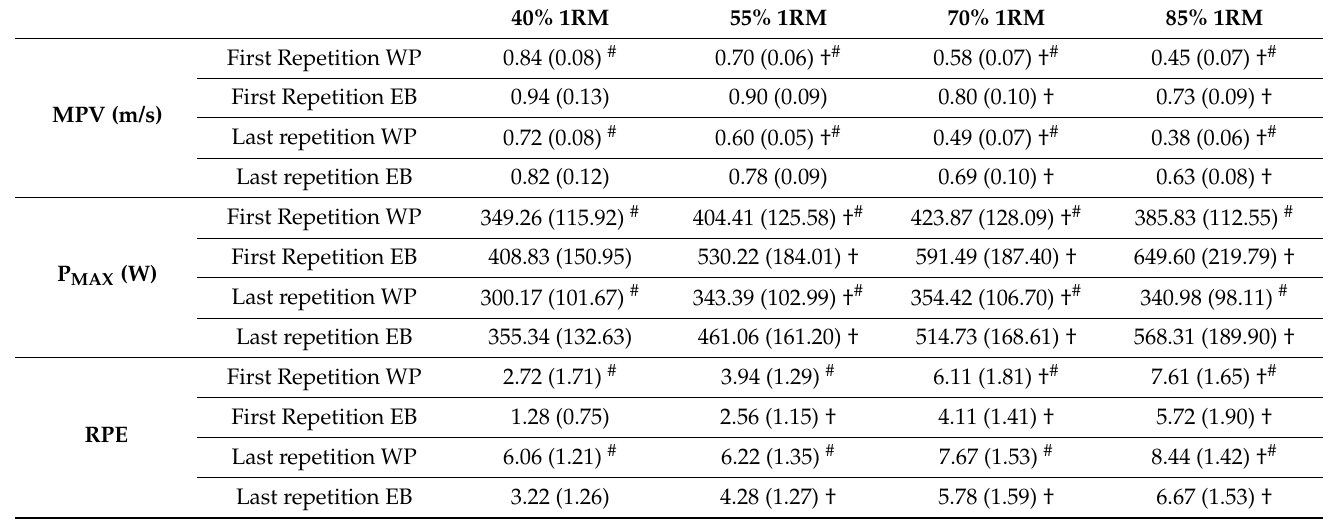
Table 2. MPV, P MAX , and RPE values for the first and last